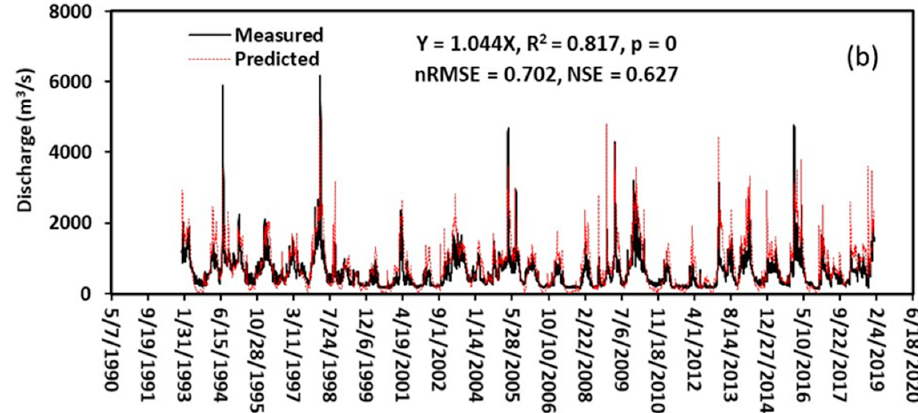
Figure 2. Comparison of the observed and predicted daily discharges during model calibration ( a ) and validation ( b ).